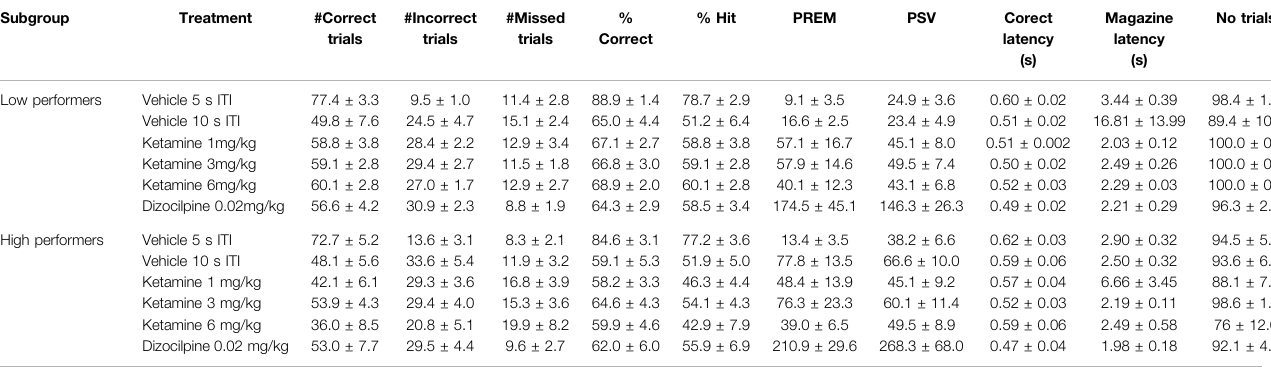
TABLE 6 | Performance measures from 5-choice serial reaction time task: Test conditions of extended ITI, i.e. 0.3 s SD, 10 s ITI, 100 trials. Ketamine “ low ” and “ high ” performers (N (cid:1) 8 per subgroup). Subgroup